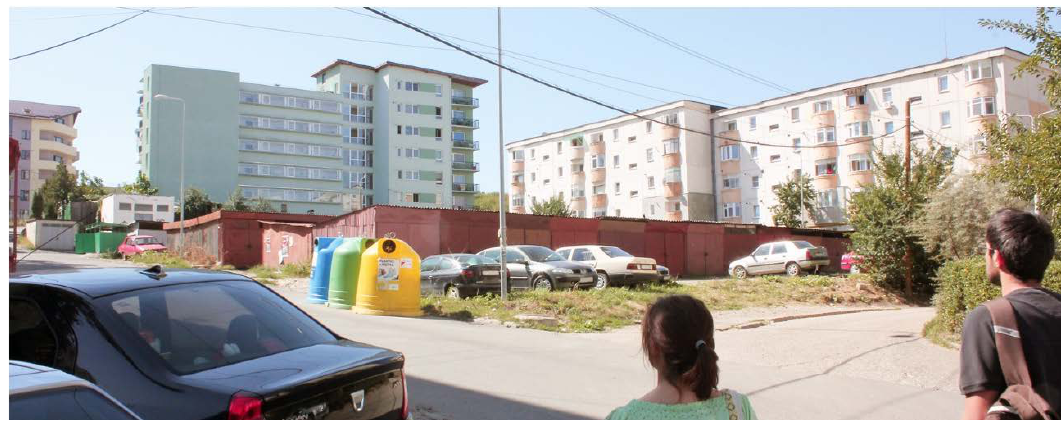
Figure 9: More garages in M